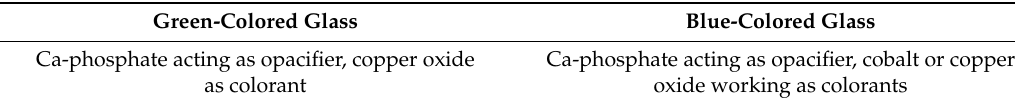
Table 7. Ca-phosphate